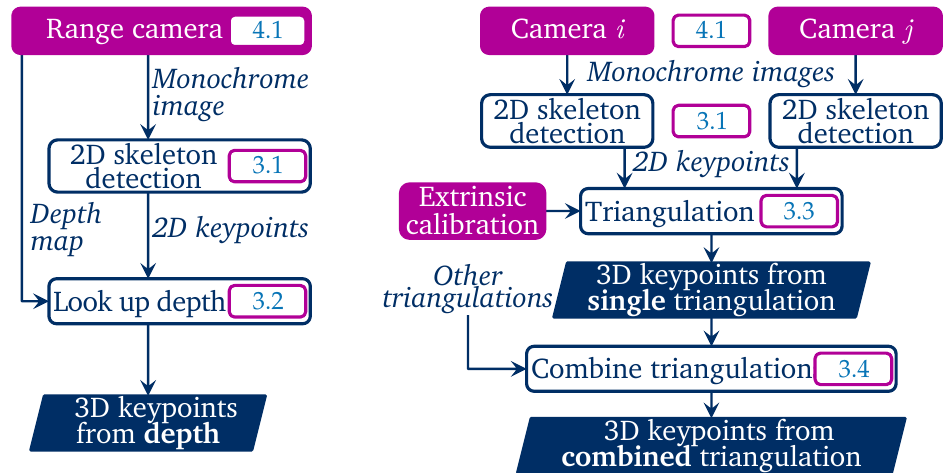
Figure 1. Block diagram of the 3D skeletonization algorithms with section numbers: based on range camera depth ( left ), based on single or combined triangulation ( right